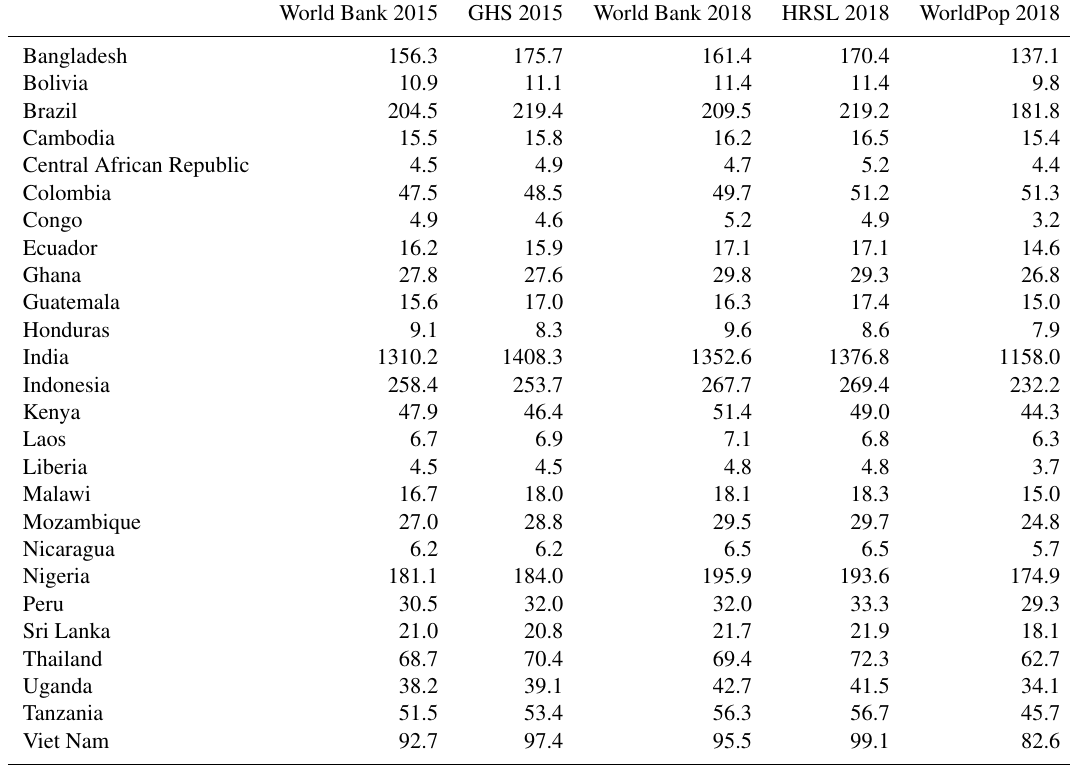
Table A7. Total country population (millions) using data from the World Bank (The World Bank, 2021a), GHS, HRSL, and WorldPop for 26